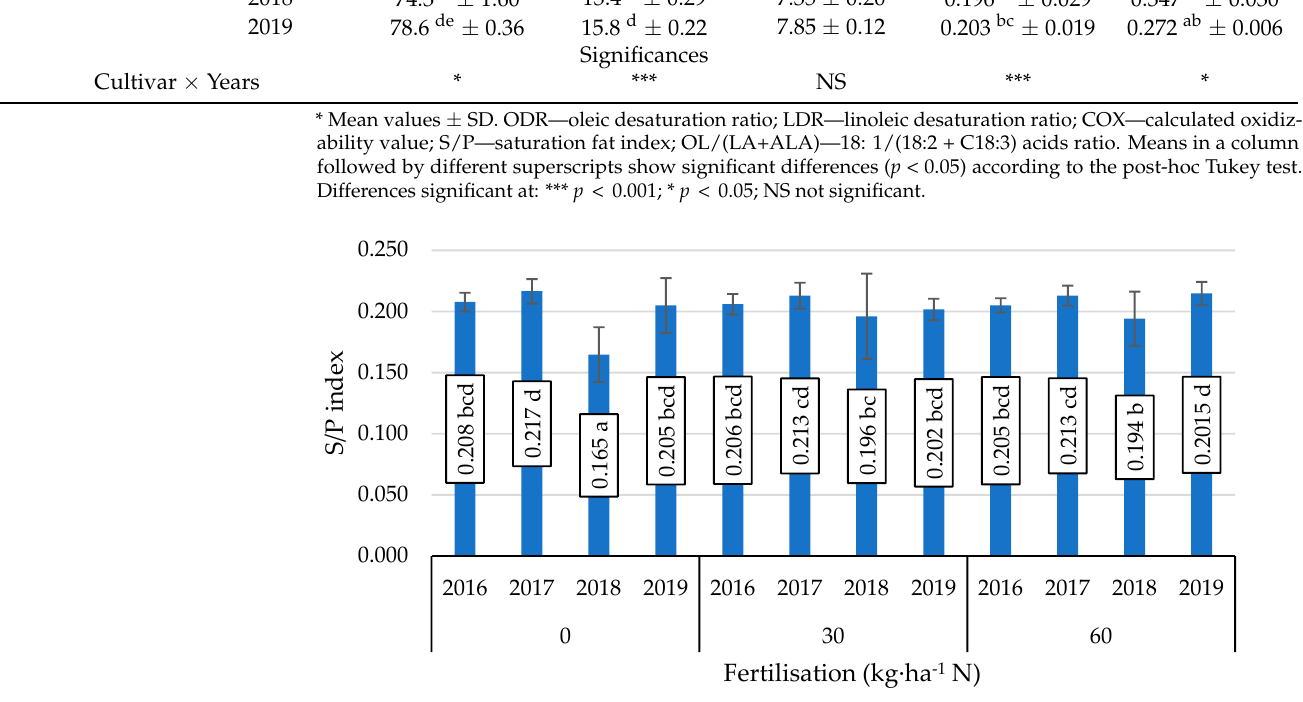
Figure 2. Value of the saturation fat index (S/P), mean values for interaction inoculation × years. Mean values ± SD. Means followed by different letters show significant differences ( p < 0.05) accord- ing to the post-hoc Tukey test. Differences significant at: * p < 0.05.